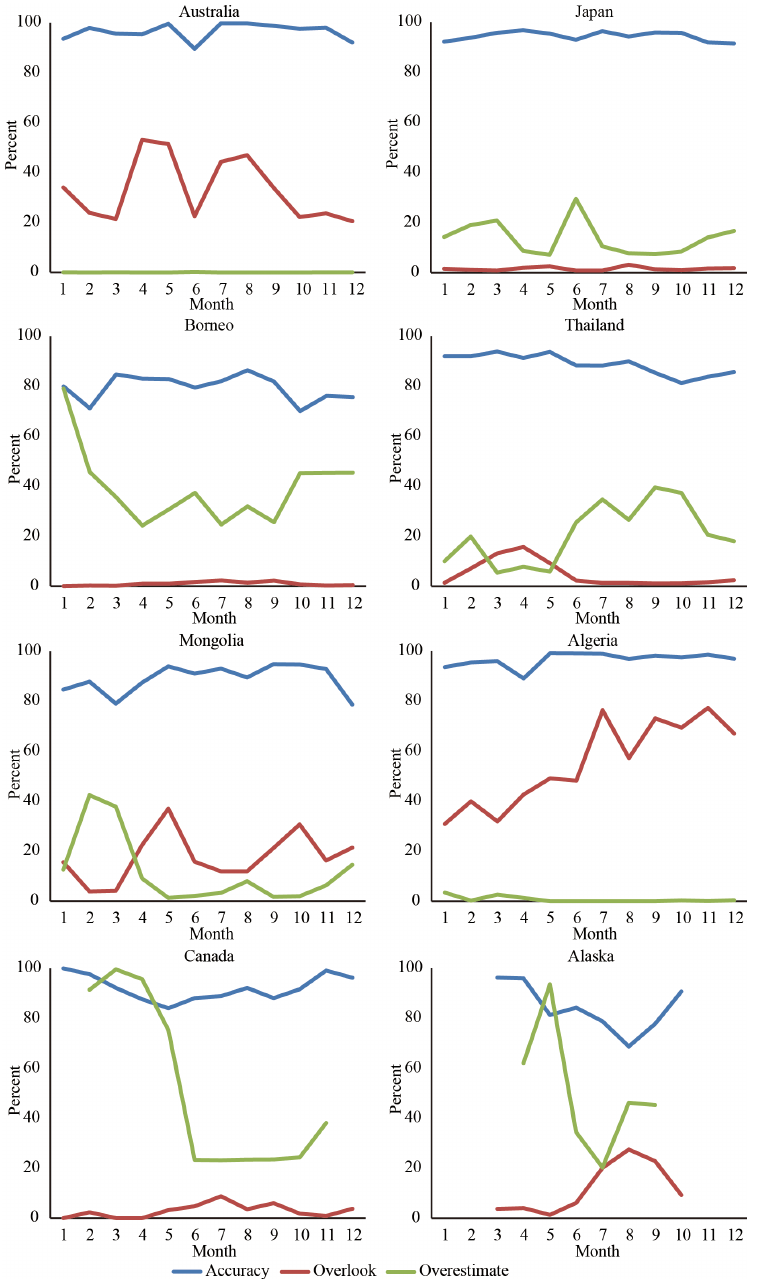
Figure 9. Monthly average accuracy, overlook, and overestimate for various land cover types. Blue line indicates accuracy, red line indicates overlook, and green line indicates